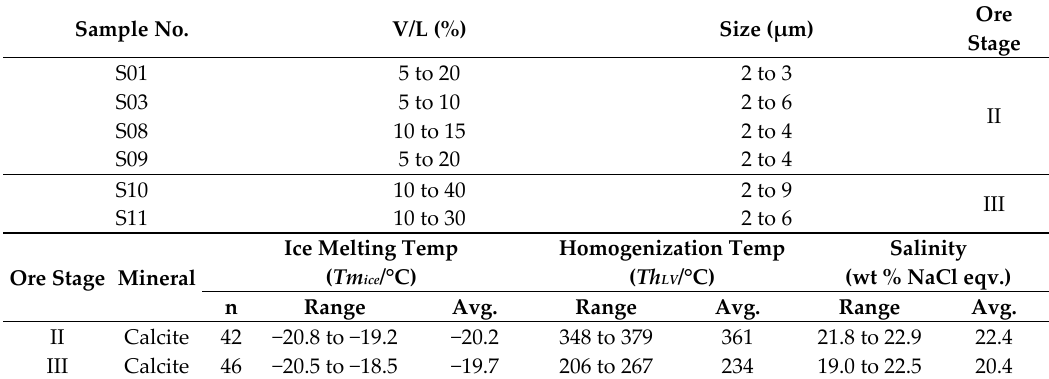
Table 1. Features of fluid inclusions in ore-related calcite from Xianglushan orefield. Sample No.